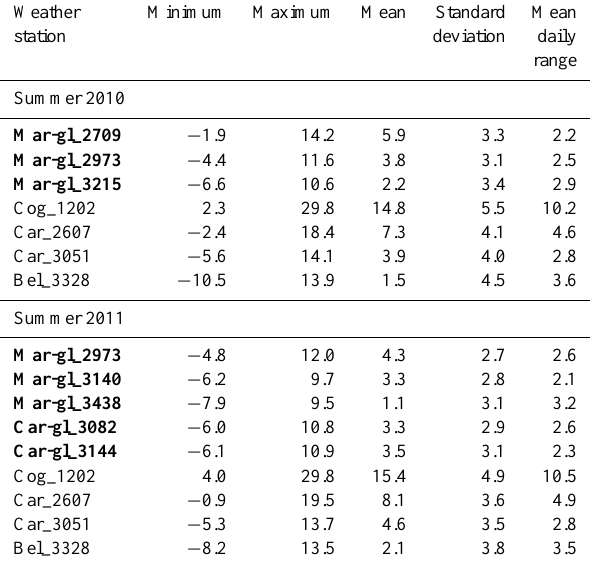
Table 2. Descriptive statistics for air temperature data recorded by the weather stations. On-glacier sites are in bold type.